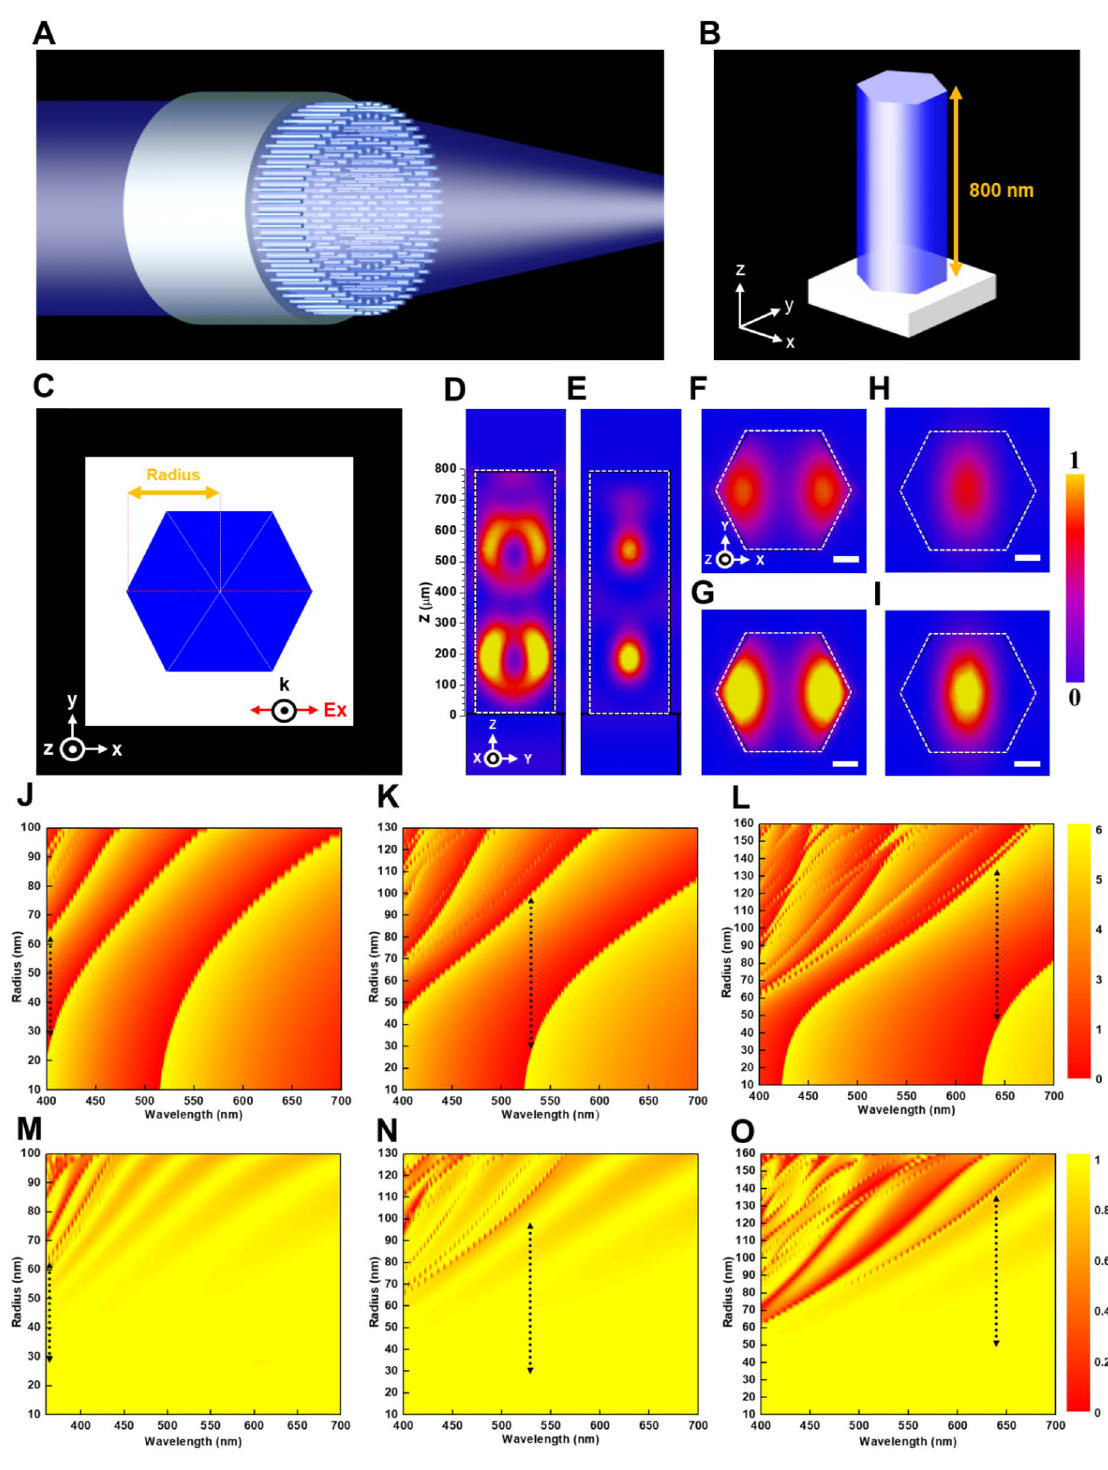
Figure 1. Design and simulation of the building block for metalenses. ( A ) Schematic of a dielectric metalens operating in a transmissive mode. ( B , C ) Schematics of the tilt-view and top-view of the building block for the metalens composed of the HREs. ( D , E ) Simulated electric and magnetic field intensity distribution. ( F , G ) The x–y cross-sections of simulated electric field intensity distribution at z = 500 and 200 µm, individually. ( H , I ) The x–y cross-sections of simulated magnetic field intensity distribution corresponding to ( F , G ). Scale bar, 50 nm in ( F – I ). ( J – L ) Diagrams showing the range of phase modulation for the building block periods of 200, 260, and 320 nm on the combinations of wavelength and radius profiles for the metalenses designed at wavelengths of 405, 532, and 633 nm, respectively. ( M – O ) Simulated efficiencies of the metalenses designed at the wavelengths of 405, 532, and 633 nm, respectively. The black dashed lines represent the implemented radius range for the